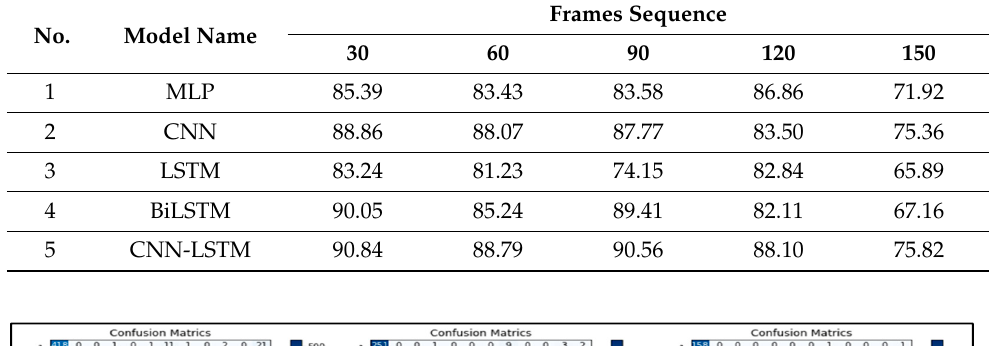
Table 7. Recall Score of the proposed method and other DL models on different sequences.